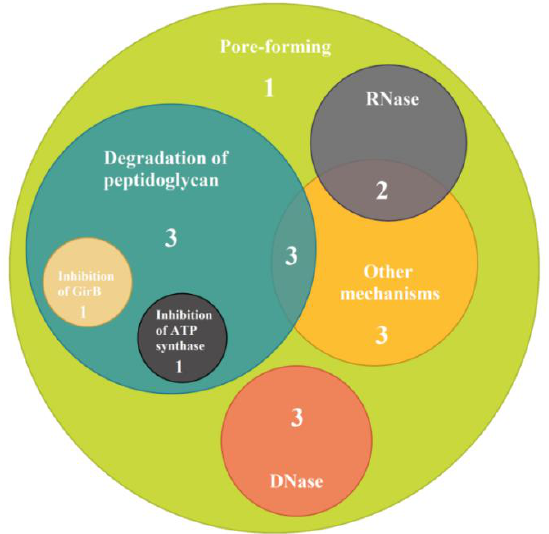
Figure 1. Combinations of bacteriocin genes with different modes of actions (the number reflects the number of strains with corresponding combinations of modes of actions). Table 4. Inhibition of the growth of pathogenic E. coli in the presence of CFS of bacteriocin-producing E. coli . Inhibition Index, % Strain APEC IPEC BR4 BR35 BR37 CA29 CA43